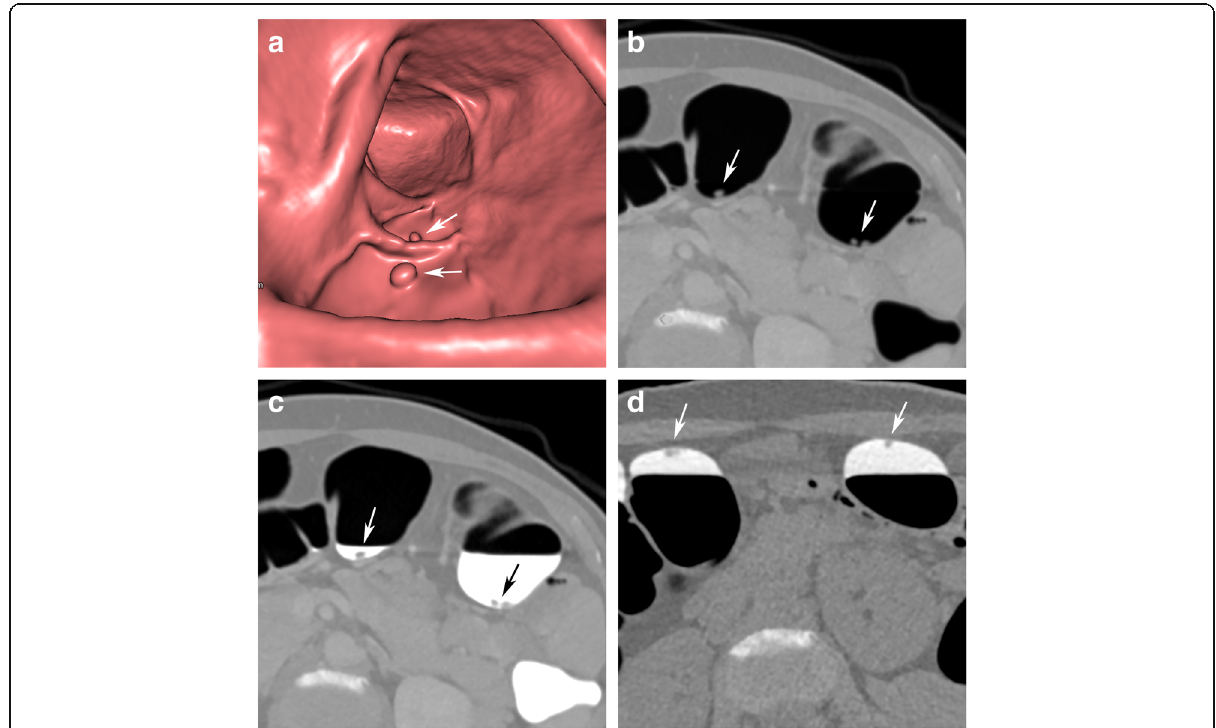
Fig. 3 Pseudopolyps due to particles of untagged faecal residue in the transverse colon. a Endoluminal 3D and ( b ) axial 2D view after EC, showing multiple small sessile polypoid filling defects (arrows). On corresponding unsubtracted ( c ) prone and ( d ) supine 2D views, the filling defects shift with the residual fluid from the dorsal to the anterior section of the transverse colon (arrows). They are not connected to the colonic wall. This is a typical imaging feature of faecal